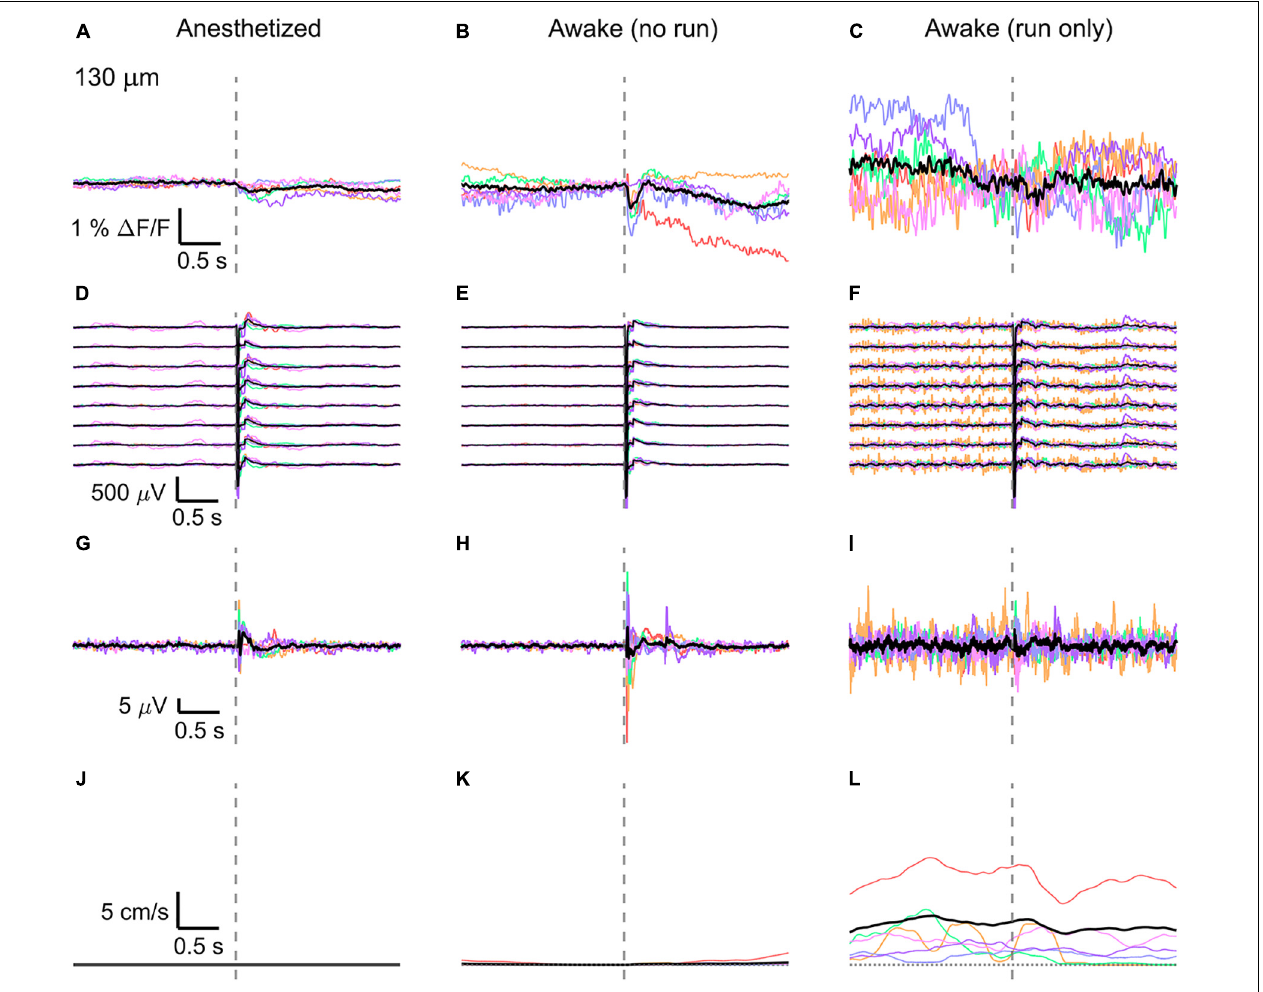
FIGURE 4 | Average VSD signal 130 µ m below dura and LFP, both in barrel cortex, ECoG, and running speed in response to a facial air puff (six mice). Average VSD responses evoked by an air puff to the vibrissae and cheek of the mouse in layer II (130 µ m below dura) recorded in 375 × 24 × 5 µ m 3 and 375 × 12 × 5 µ m 3 box-scans in six mice (A) during anesthesia (135, 187, 139, 139, 130, 138 trials), (B) in awake mice during resting (109, 195, 125, 125, 96, 124 trials), and (C) in awake mice during running (19, 1, 7, 8, 13, 11 trials). (D–F) Corresponding average LFP recorded by 8 electrodes (every 4 th channel of the linear probe, tip at 850 µ m below dura, bottom LFP trace: 800 µ m, top LFP trace: 100 µ m below dura, (cid:49) depth = 68 µ m between adjacent traces). Corresponding (G–I) average ECoG and (J–L) average speed. Each mouse is indicated by a different color; the overall average is shown in black. Gray dashed line marks the air puff